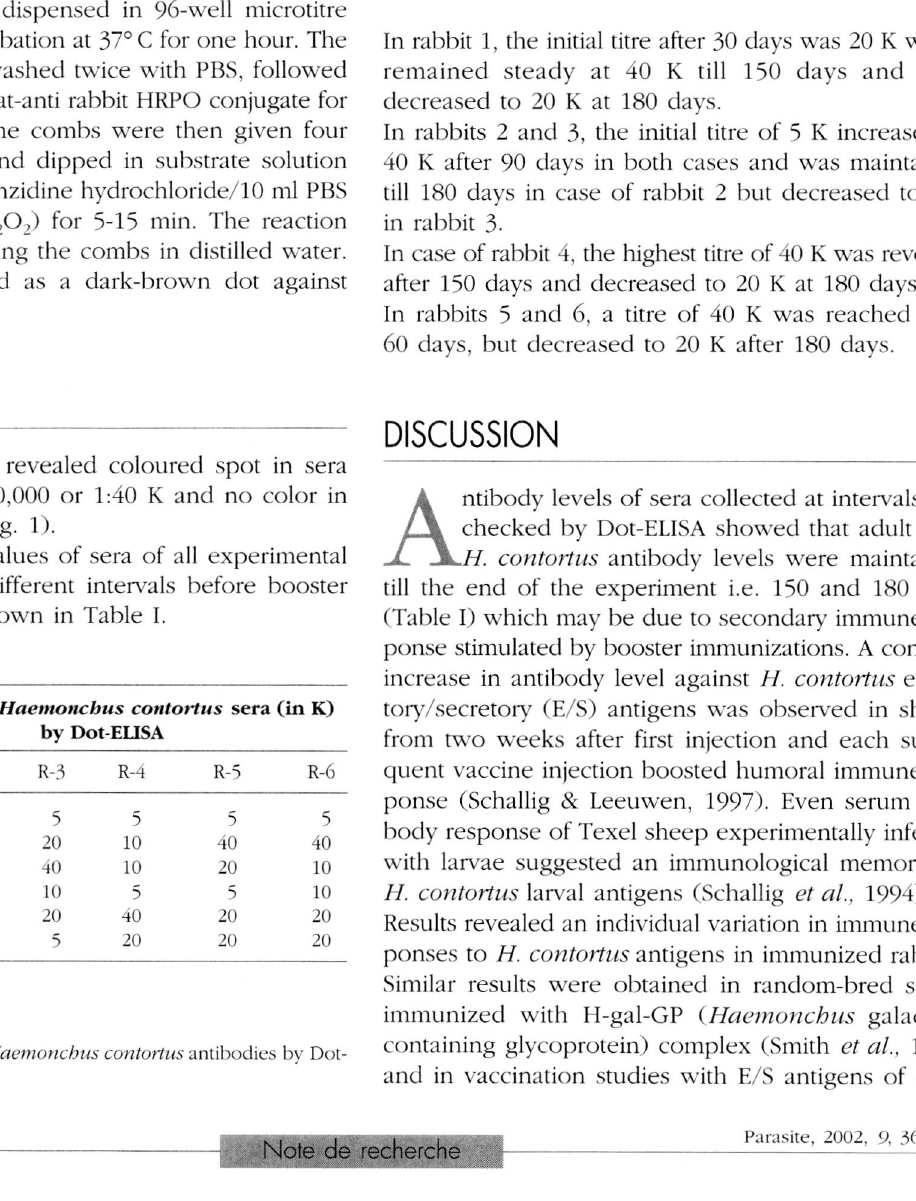
Table I. - Kinetics of anti-Haemonchus contortus antibodies by Dot- ELISA.